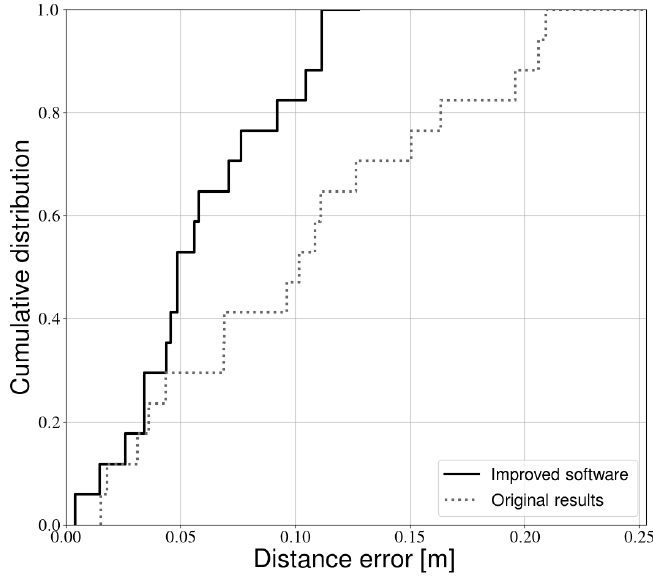
Figure 6. Cumulative error distribution of this paper compared with our previous work